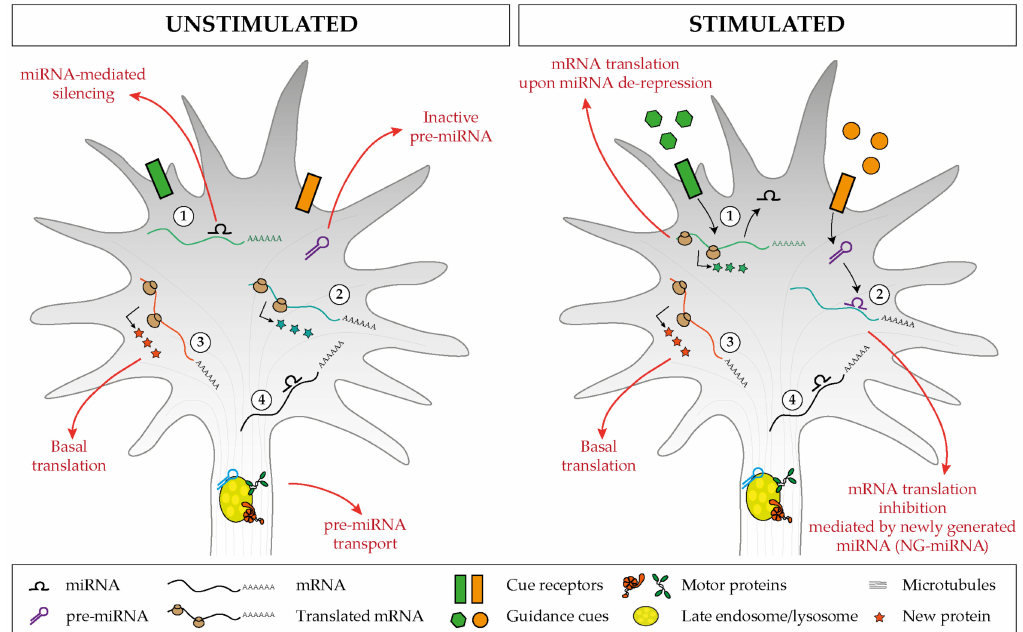
Figure 6. ProposedmodelofmiRNA-mediatedregulationofbasalandcue-inducedtranslation. (1)Specific miRNAs keep a subset of mRNAs in an untranslated state, but upon stimulation, the miRNA-mediated silencingisrelieved,andthisinducesaburstofmRNAtranslation.(2)Inactivepre-miRNAsaretransported and stored within the axonal compartment (left), and upon cue exposure (right), distinct pre-miRNAs are locally processed and the associated newly generated miRNAs (NG-miRNAs) inhibit the basal translation of given transcripts. Regardless of the stimulus status, (3) specific transcripts undergo basal translation and (4) others are maintained in an untranslated silent